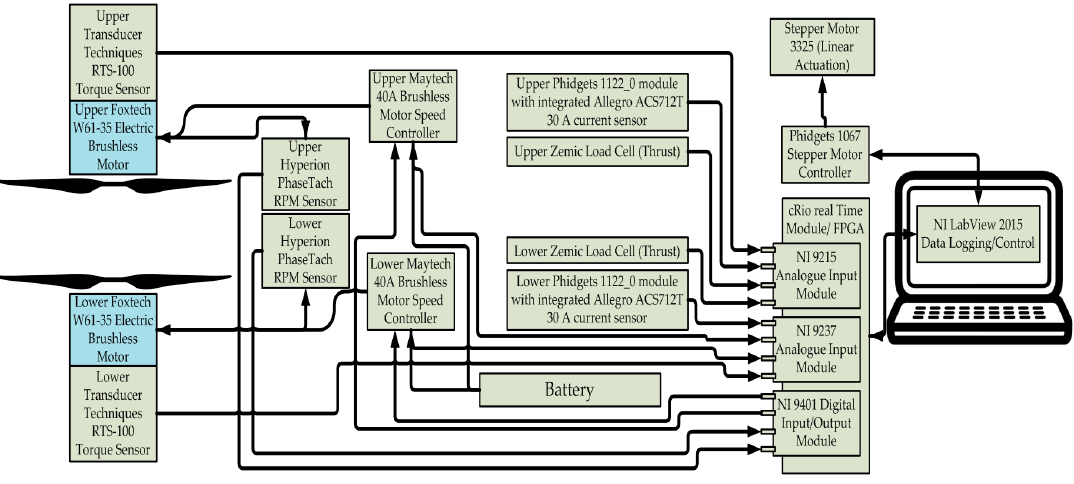
Figure 9. Test rig system diagram.